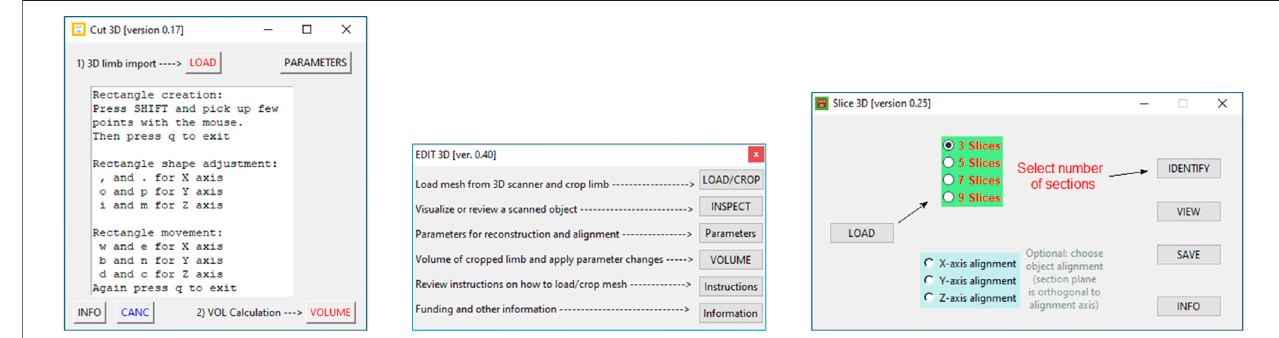
Figure 1 . Edit 3D can import three mesh fi le formats: stereolithography ( fi le extension is “ STL ” ), object fi les ( “ OBJ ” fi le extension), and polygon fi le format ( “ PLY ” fi le extension, also known as Stanford polygon). Cut 3D can open the same fi le types as Edit 3D but also polygon fi le format fi les containing point clouds. Both Edit 3D ( “ Parameters ” window) and Cut 3D ( Parameters and CANC buttons) offer functions that can manage special operations on the input data. In addition, they can be combined into customized analysis